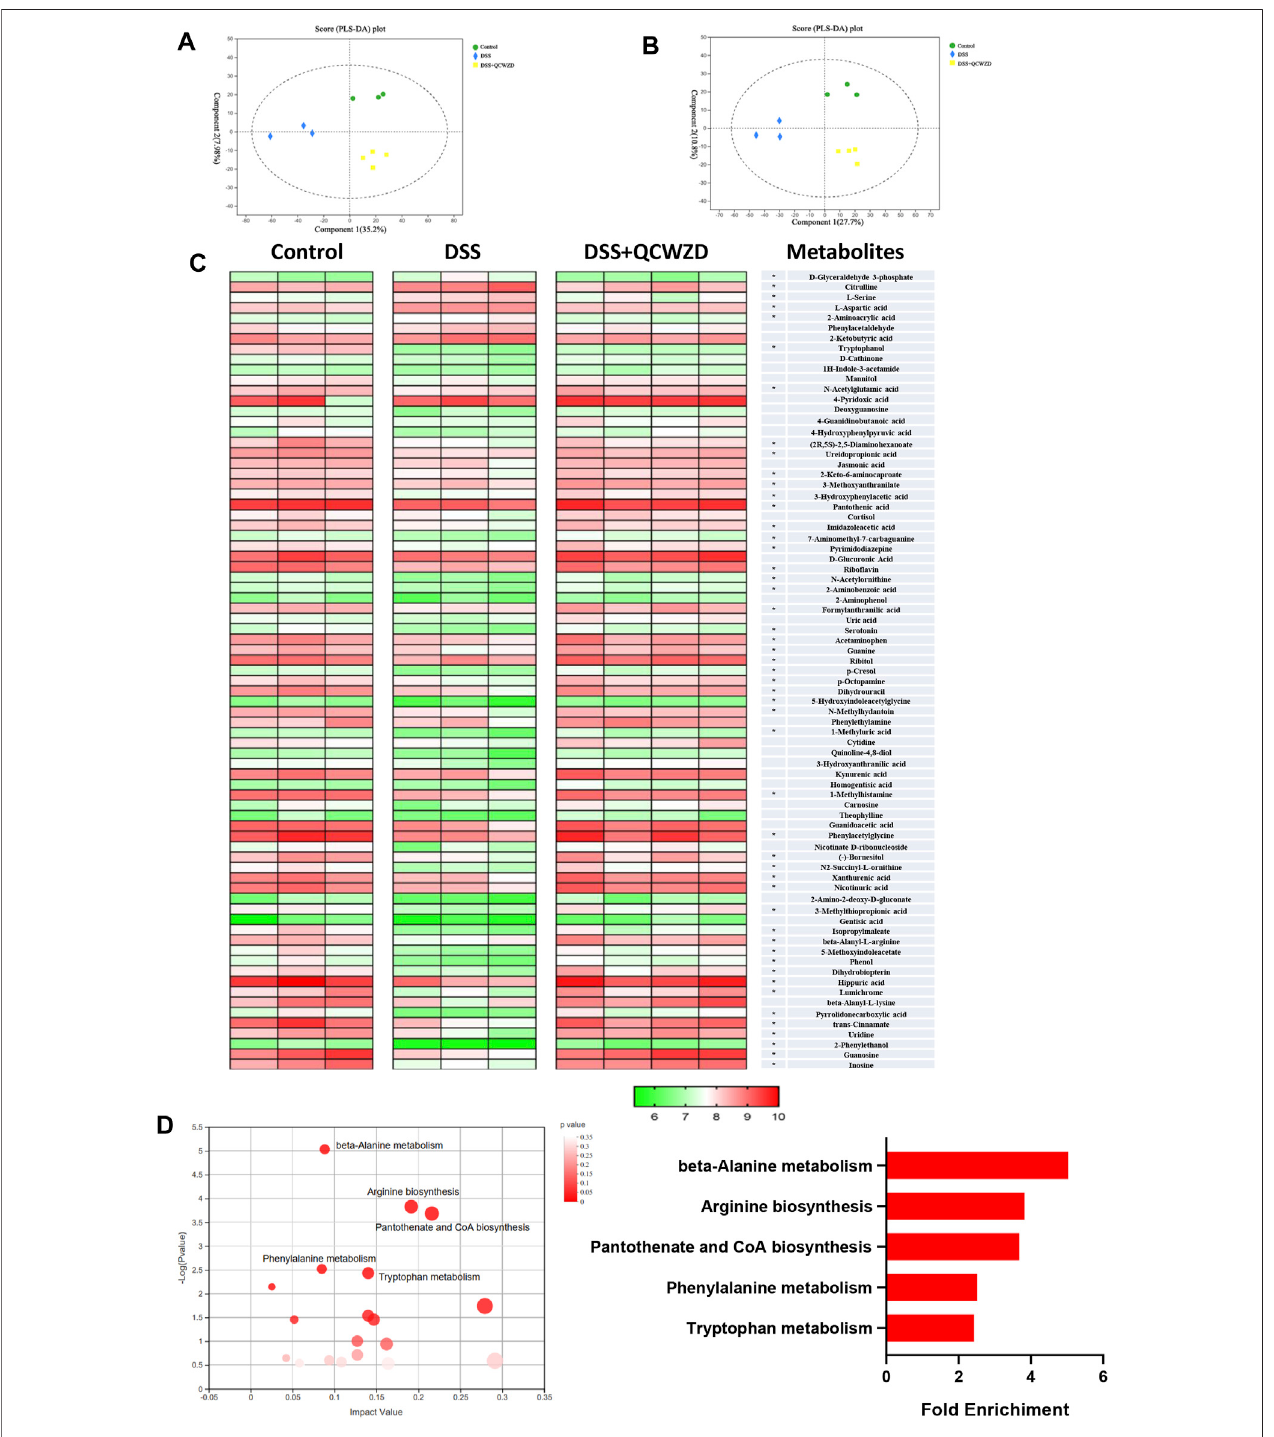
FIGURE 6 | Metabolic Pro fi les Are Altered by QCWZD Treatment in DSS-Induced Colitis Mice. Fresh fecal samples from each mouse were collected for LC/MS- based untargeted metabolic pro fi ling ( n (cid:2) 3 – 4 mice/group). (A, B) PLS-DA plots of the fecal metabolome from all samples in the positive and negative ion modes. (C) Heatmaps of the differential metabolites that were altered by DSS feeding compared with QCWZD-fed mice with the double criteria of both VIP > 1 and p < 0.05. Each column represents an individual sample. Each column represents an individual sample. (C) Bubble diagram of metabolic pathways enrichment based on the differential metabolites among three groups. One bubble represents one metabolic pathway. Top 5 pathways were listed on the right.